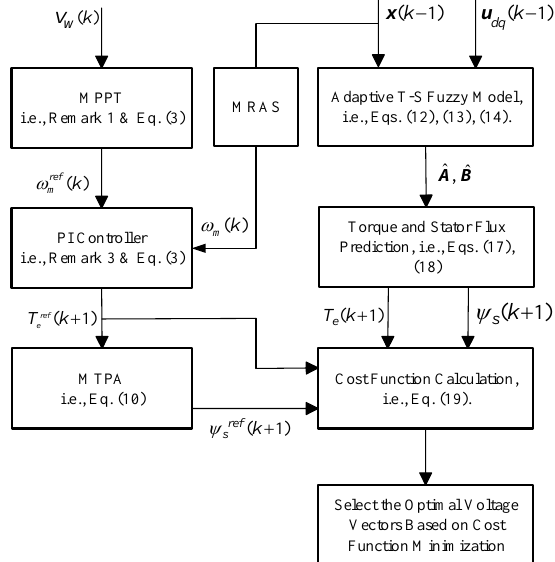
Figure 4. Flowchart of the proposed ATSFMPC control scheme.